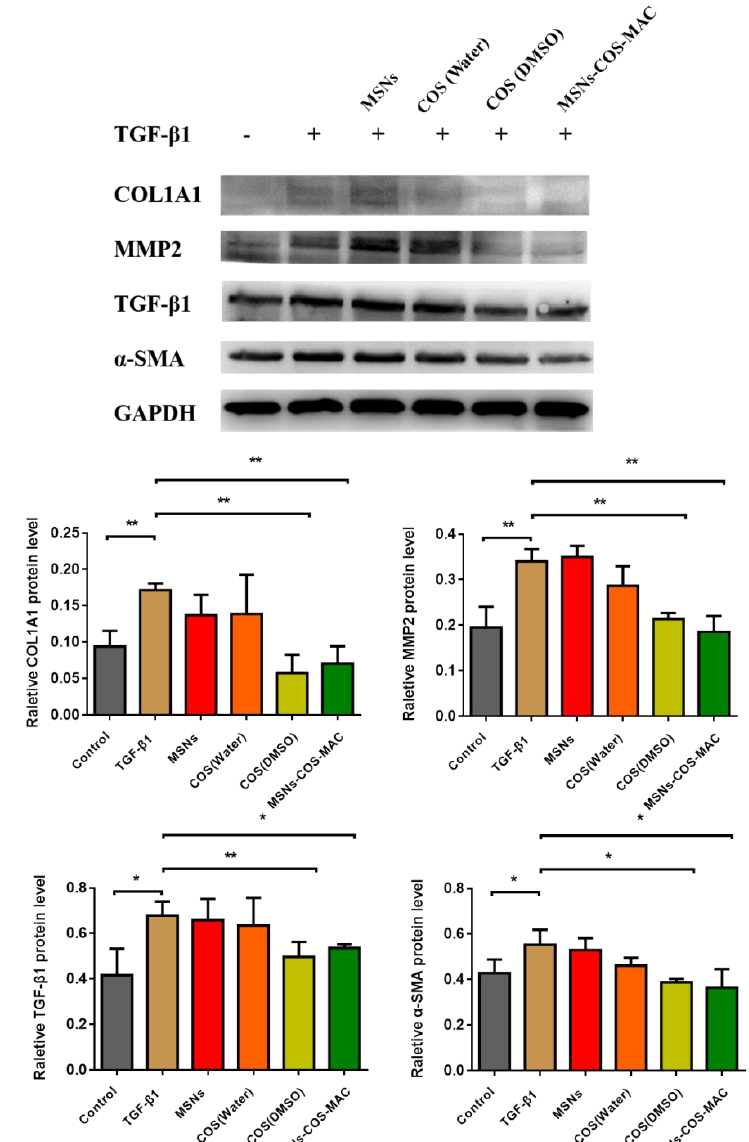
Figure 6. Effects of COS and MSNs-COS-MAC on inhibiting fibrogenetic COL1A1, α -SMA, TGF- β 1 and MMP2 protein levels in LX-2 cells. Proteins were extracted and analyzed by a Western blot analysis in the experimental section. The values are expressed as the mean ± SD of triplicate independent experiments (** p < 0.01 and * p < 0.05 vs. the TGF- β 1 group). We further studied the effects of COS and MSNs-COS-MAC on the expression of liver fibrosis-related proteins in BDL rats. The results showed that MSNs-COS-MAC and COS significantly lowered the protein expression of these fibrogenic markers. As (40 mg/kg/day) for 14 days, a decreased expression of TGF- β 1, MMP2 and α -SMA was observed, which may have been the result of the inhibition of the activation of HSCs. At a half dose of COS, MSNs-COS-MAC showed a stronger anti-fibrotic effect. These findings indicate that MSNs-COS-MAC could inhibit the progression of fibrosis more effectively than COS in BDL